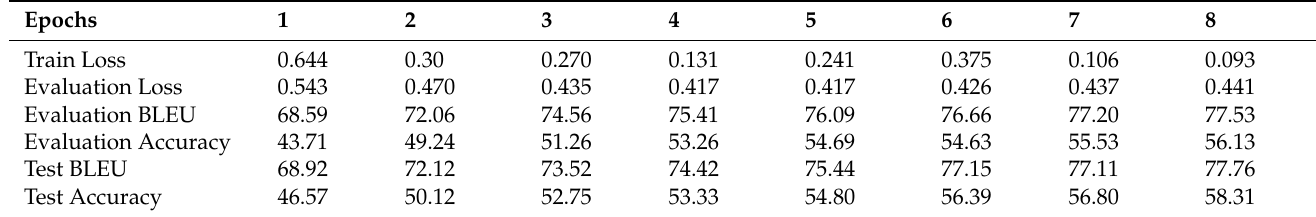
Table 5. The performance of BART large using Django dataset and 8